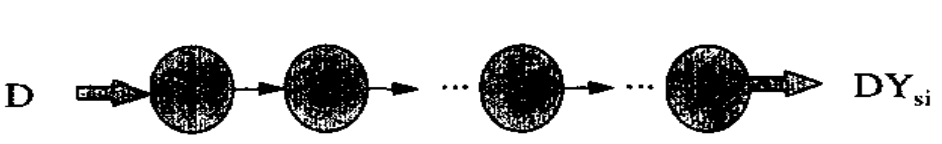
Figure 4. A schematic diagram of compartmental model with linear transfer kinetics. Reprinted with permission from Ref. [38]. 1996, Elsevier.